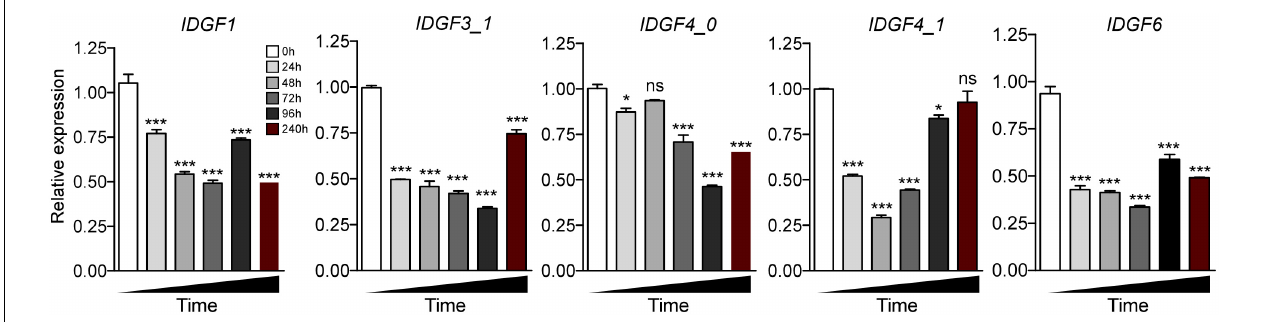
FIGURE 5 | Relative expression pattern of IDGFs in different time intervals post feeding to dsRNA or dsGFP or DEPC were determined as mean ( ± SE) of the three biological replicates, and two flies were used per pooled RNA sample with control as the calibrator, i.e., cDNA from non-RNAi flies (only fed on artificial diet with DEPC-water and dsGFP). EF1 α is used as the internal control. One-way ANOVA with post hoc Tukey test was used to test the statistical significance * p < 0.05; ** p < 0.01; *** p ≤ 0.001, ns: not significant.